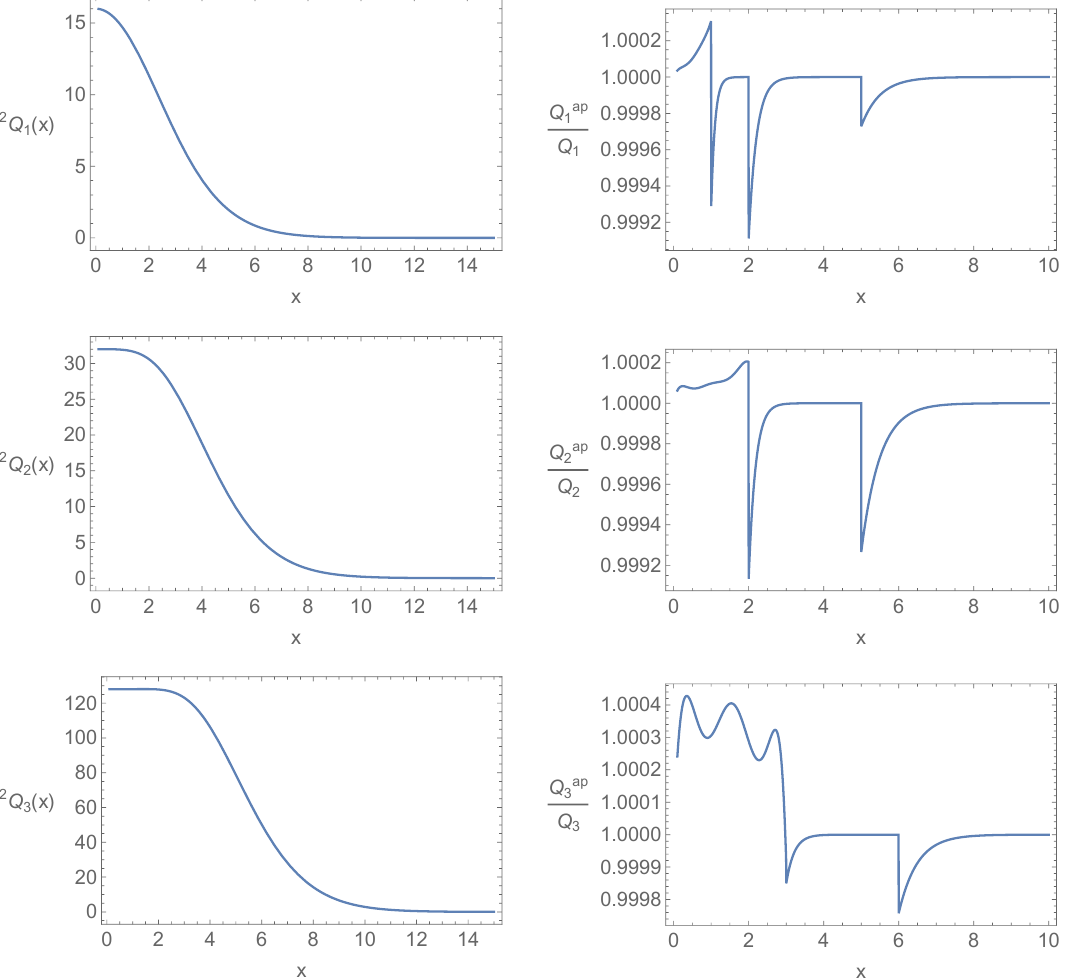
Figure 3. The profiles of x 2 Q i ( x ) ( i = 1 , 2 , 3 ) (left plots), and the ratios to their approximate functions defined in (3.39) (right plots). We have used ˜ Q